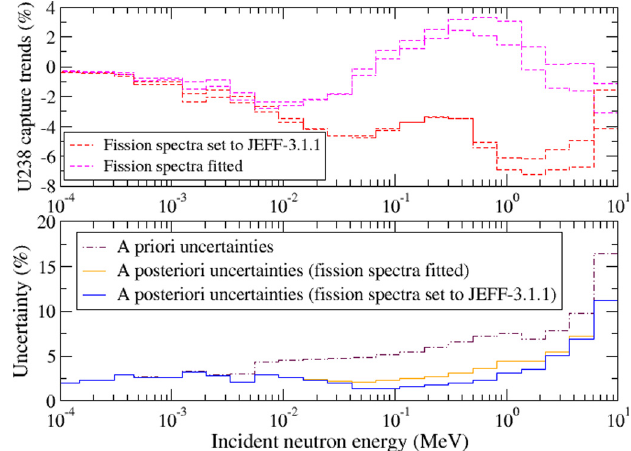
Fig. 8. 33-group assimilation results for 235 U capture compared with “ a priori ” JEFF-3.1.1 and JEFF-3.3t3 evaluation. Posterior uncertainties for assimilation results are in dotted line.